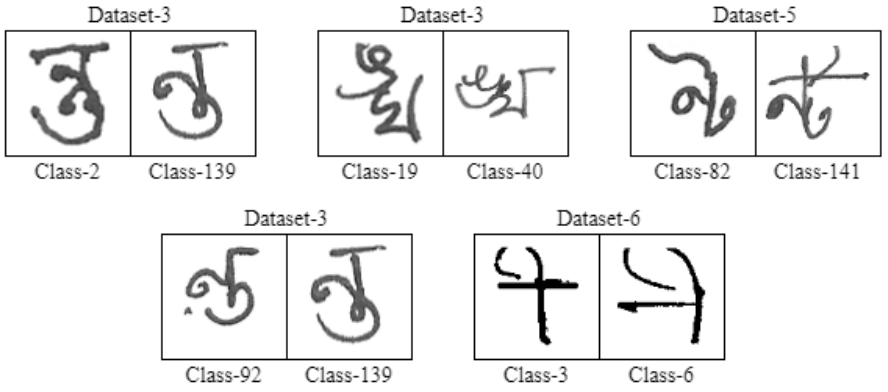
Figure 11. Examples of extremely similar classes for different